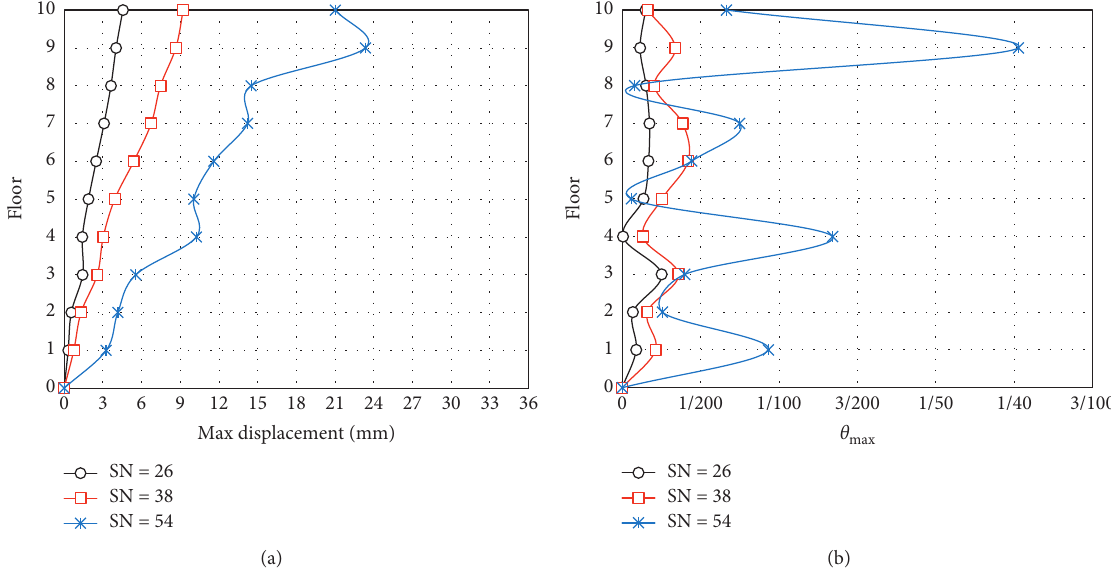
Figure 25: EnvelopediagramsofthedisplacementresponseunderElCentroearthquake.(a)Maximumlateraldisplacement.(b)Interstorydriftangle.